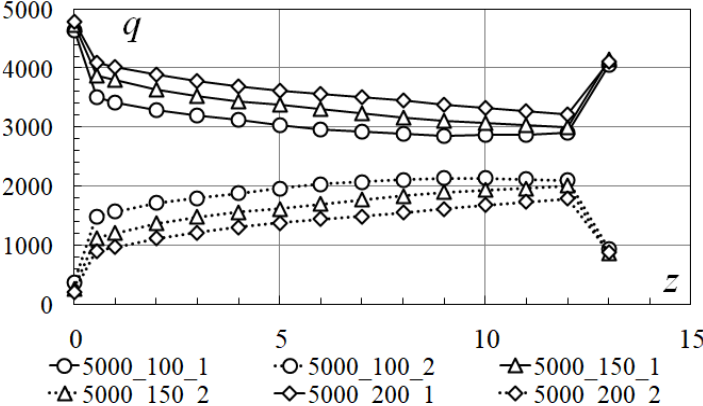
Figure 8. Distribution of the heat flow density q [W/m 2 ] by the length of the duct z [m]: q 0 − Const ; G − Varia